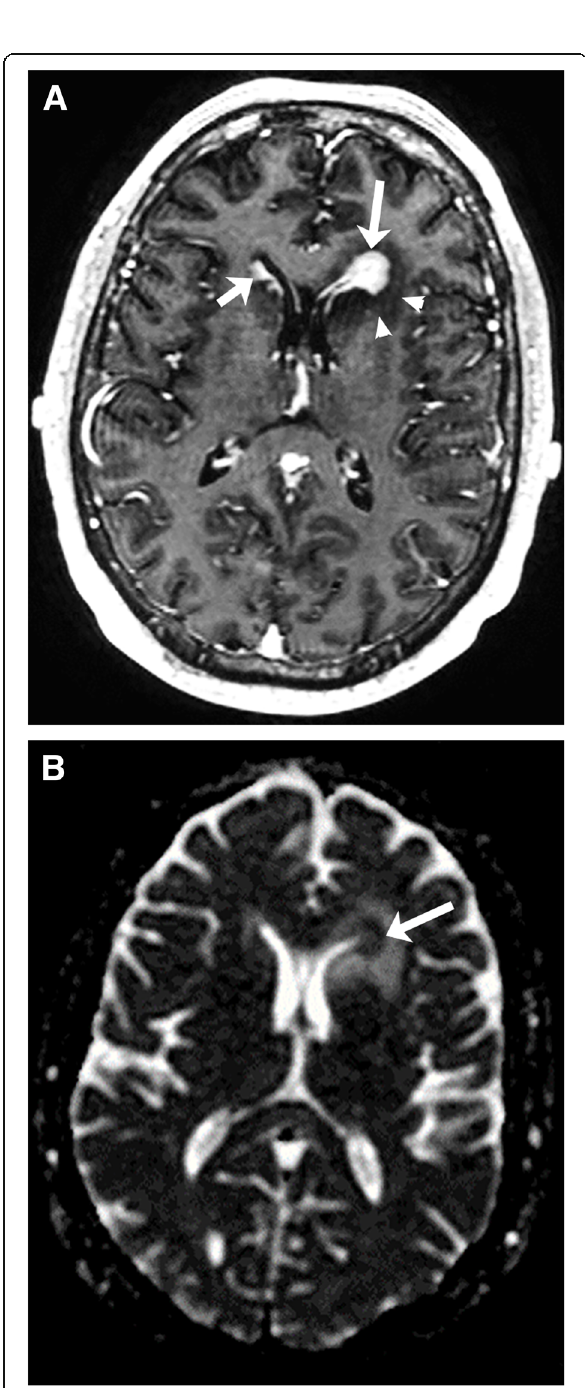
Fig. 7 Primary central nervous system lymphoma. T1-weighted image with gadolinium ( a ) shows a diffusely enhanced lesion (long arrow) in the periventricular left frontal horn with mild surrounding vasogenic edema (arrowheads). Also, note the ependymal enhancement along the right frontal horn (short arrow). ADC map ( b ) shows homogeneous diffusion restriction